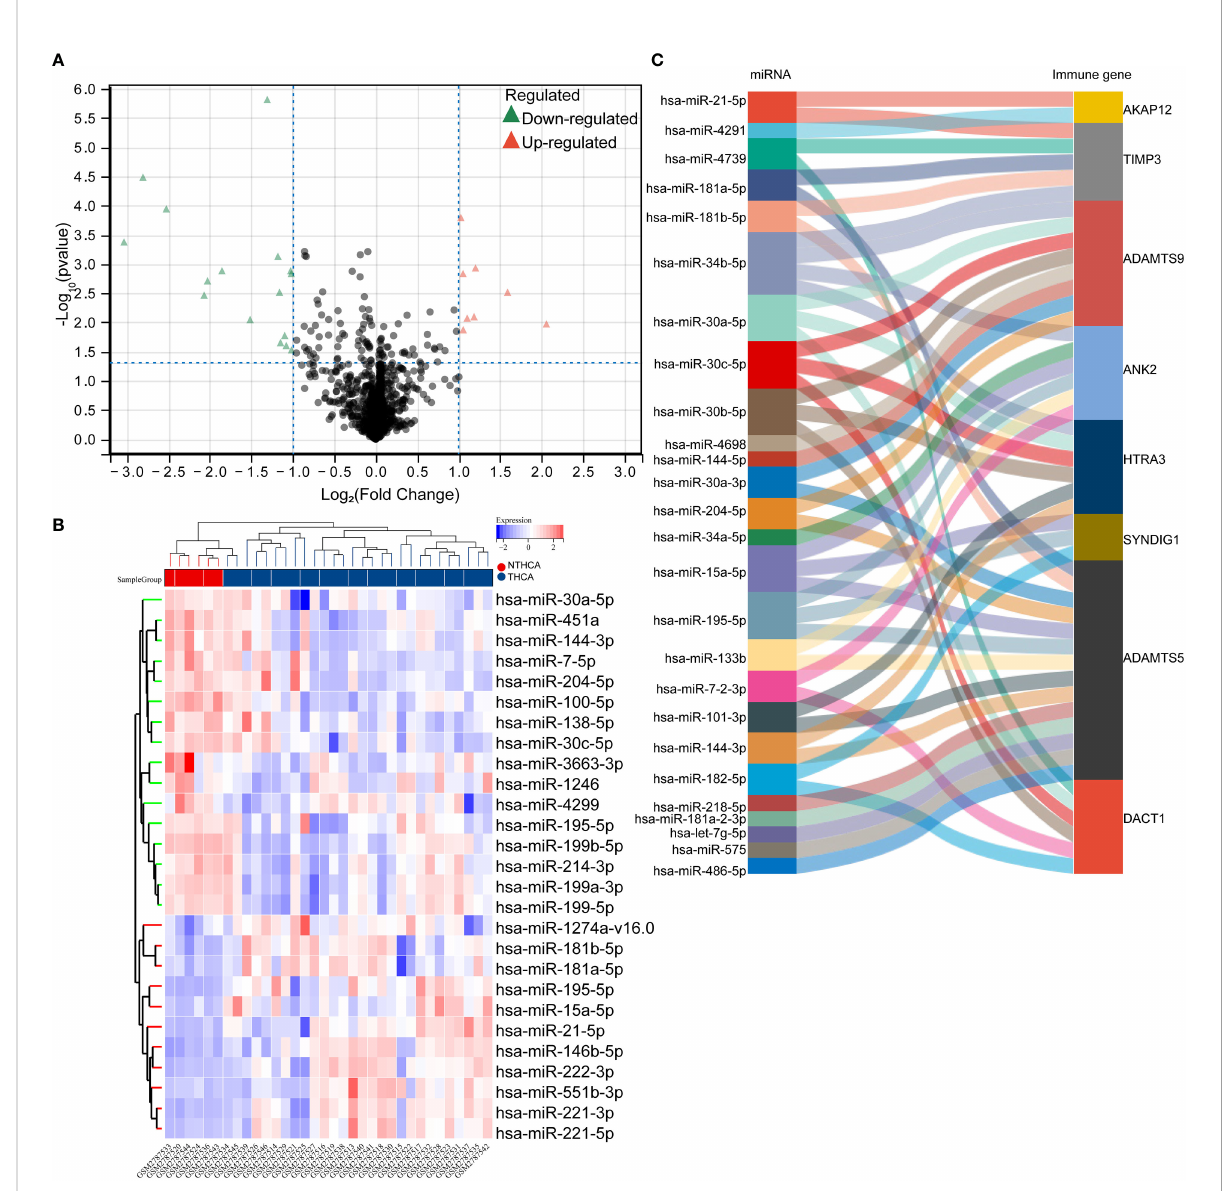
FIGURE 3 Targeted regulation of differentially signi fi cant miRNAs that regulate heterogeneous expression of prognostic factors. (A, B) volcano plot of differentially signi fi cantly expressed miRNAs in the GSE103996 dataset, heat map; (C) Sankey plot of miRNAs that target predicted binding to prognostic